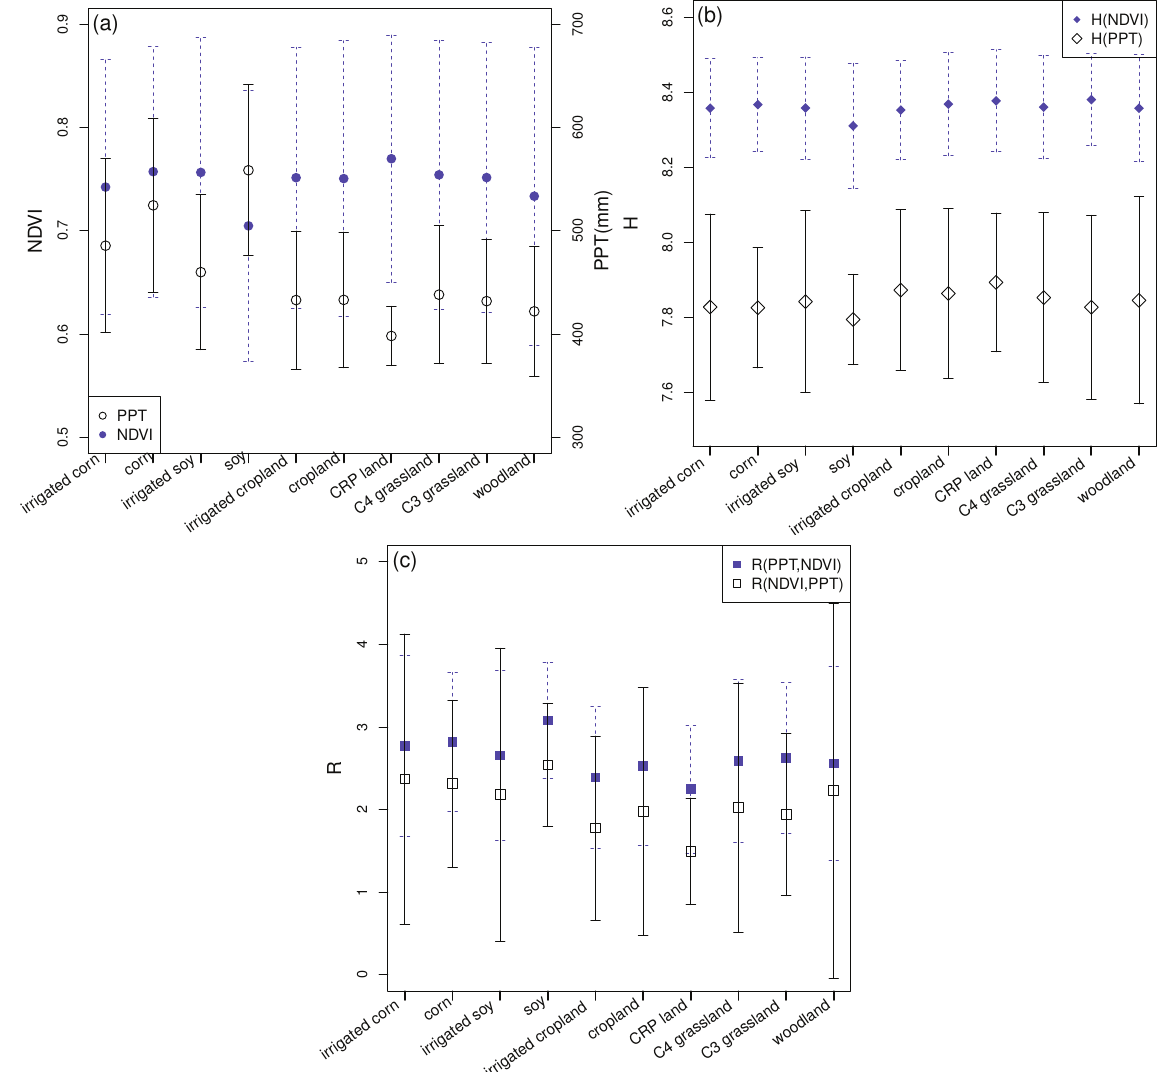
Figure 5. ( a ) Mean of maximum NDVI and PPT of 1982–2006 as a function of landcover type; ( b ) Entropy of PPT and NDVI as a function of landcover type; ( c ) Relative entropy between NDVI and PPT for each landcover type. The values of entropy and relative entropy are calculated by using the non-transformed version of PPT and NDVI, and each error bar is one standard